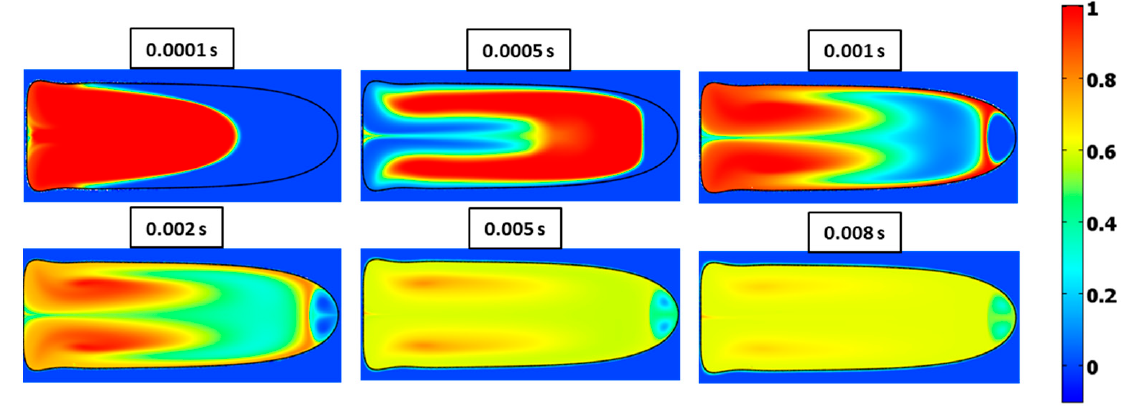
Figure 28. Surface plots of mixing at different times for 𝐶𝑎 = 0.21 and 𝜆 = 0.5 .